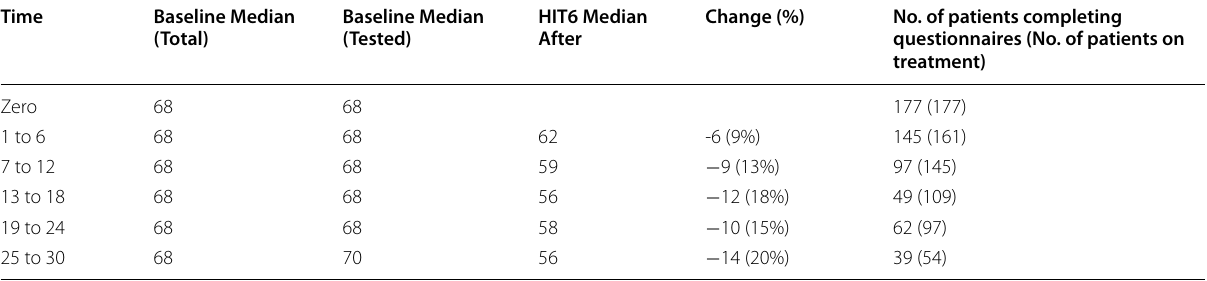
Table 2 Median HIT-6 score at baseline and follow up in months. Median difference in HIT-6 compared to baseline and percentage change in HIT-6 compared to baseline. Proportion of patients contributing to the data